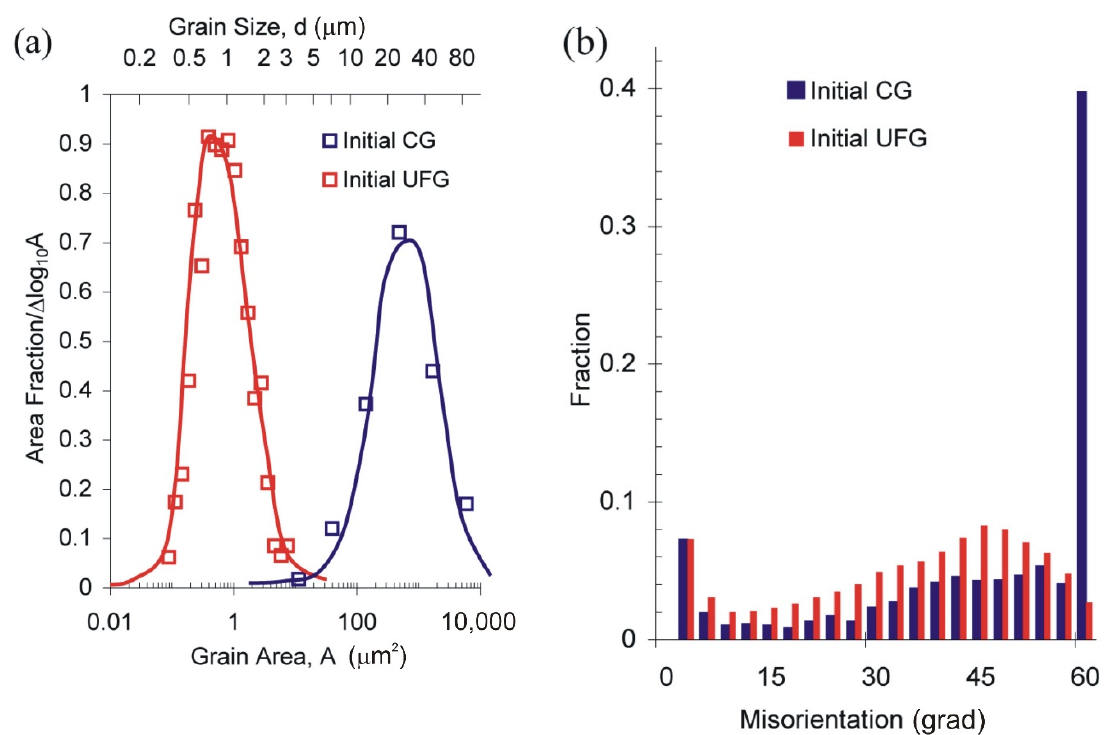
Figure 4. Normalized distributions of grain areas/diameters ( a ) and misorientation angle distributions ( b ) in nickel samples with the initial coarse grained and ultrafine grained structures.